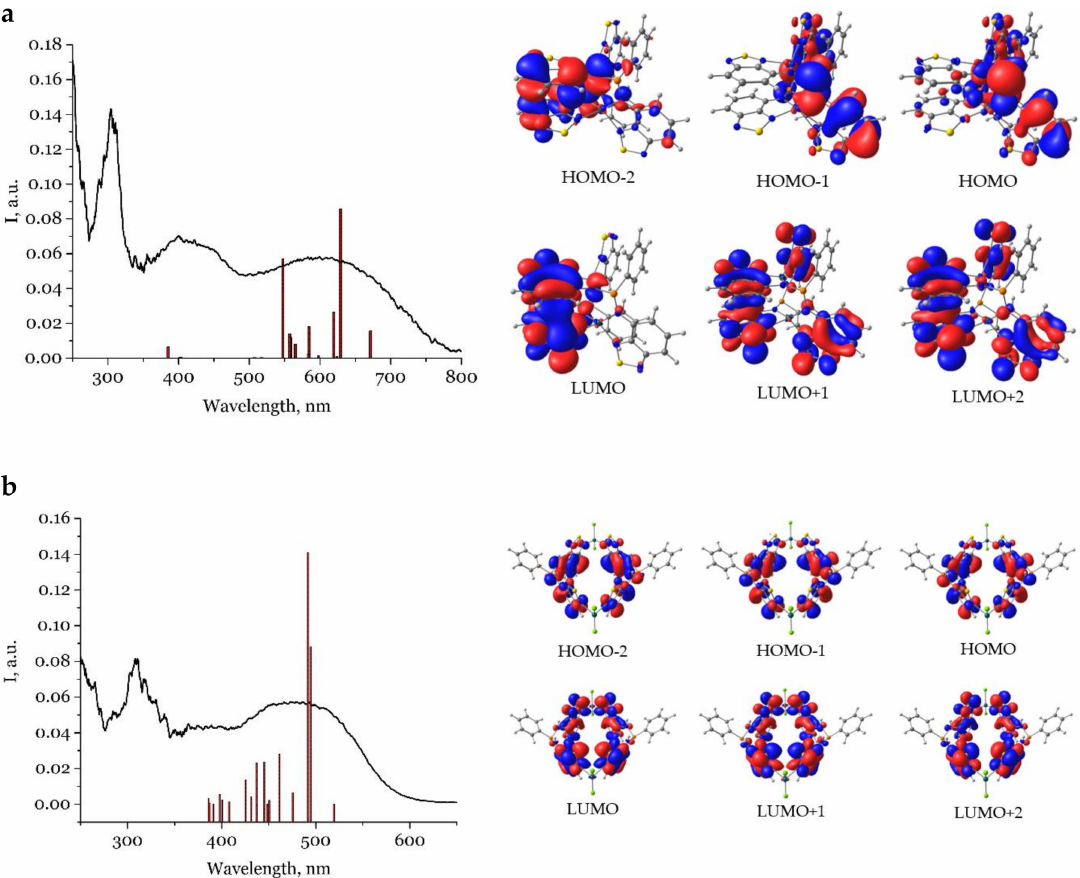
Figure 15. UV-vis spectrum and calculated transitions (left) and frontier molecular orbitals (right) of 1 ( a ) and 2b ( b ) based on TD-DFT at B3LYP / def2TZVPP level (isovalue = 0.02